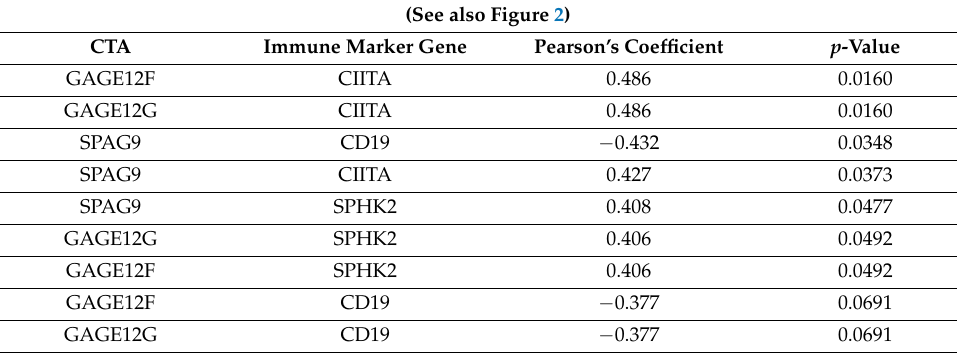
Table 1. Immune marker gene expression correlations with GBM TCR CDR3-CTA electrostatic CSs for SPAG9, GAGE12F, and